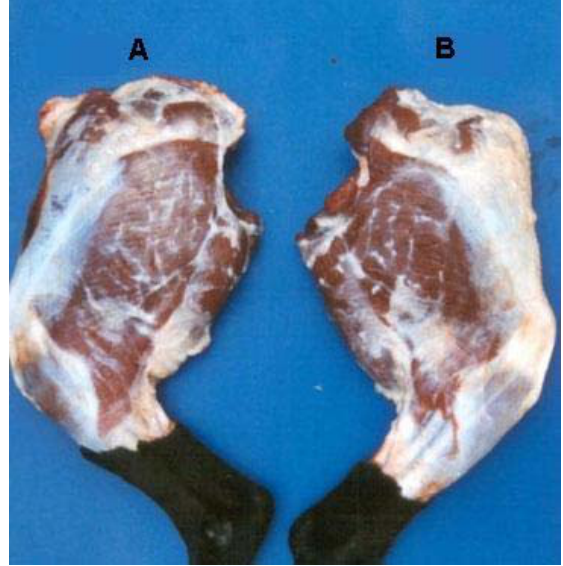
Figure 1. A: Macroscopic aspect of the muscles of the thigh from a dog experimentally envenomed with crotalic venom, showing focal areas of whitish color. B: Muscles of the contralateral hind limb of the animal in A, showing normal